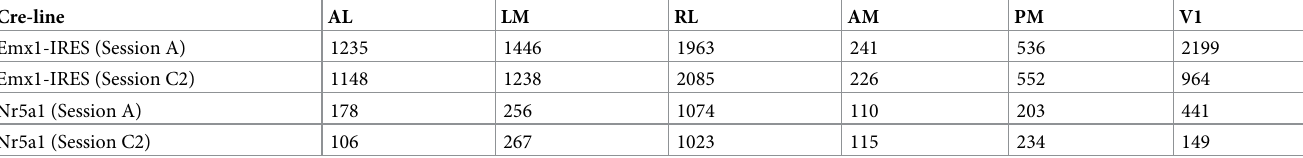
Table 2. Number of neurons available for analysis for each Cre-line and session from the Allen Institute dataset.